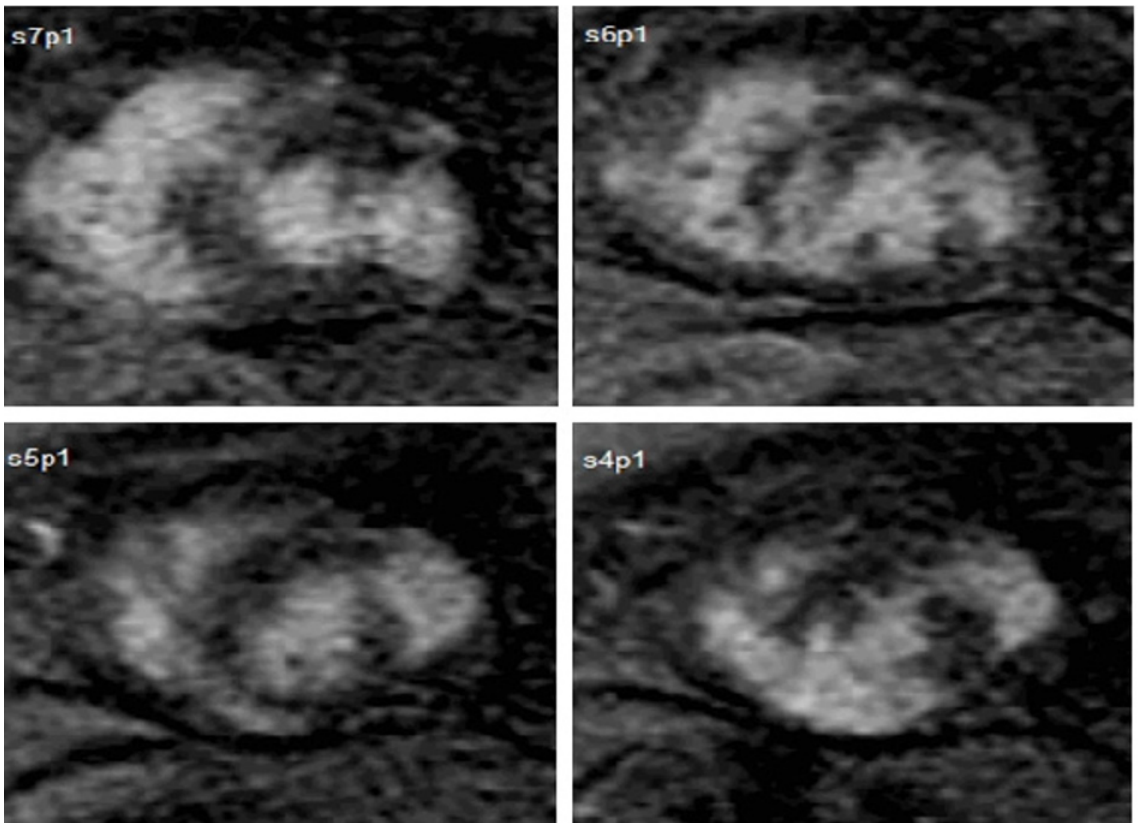
Figure 5. Cardiac MRI. Short axis view. Myocardial delayed enhancement (MDE). The dark areas present normal tissue. The patchy areas of MDE (white) depict areas of cardiac involvement in both lateral wall and